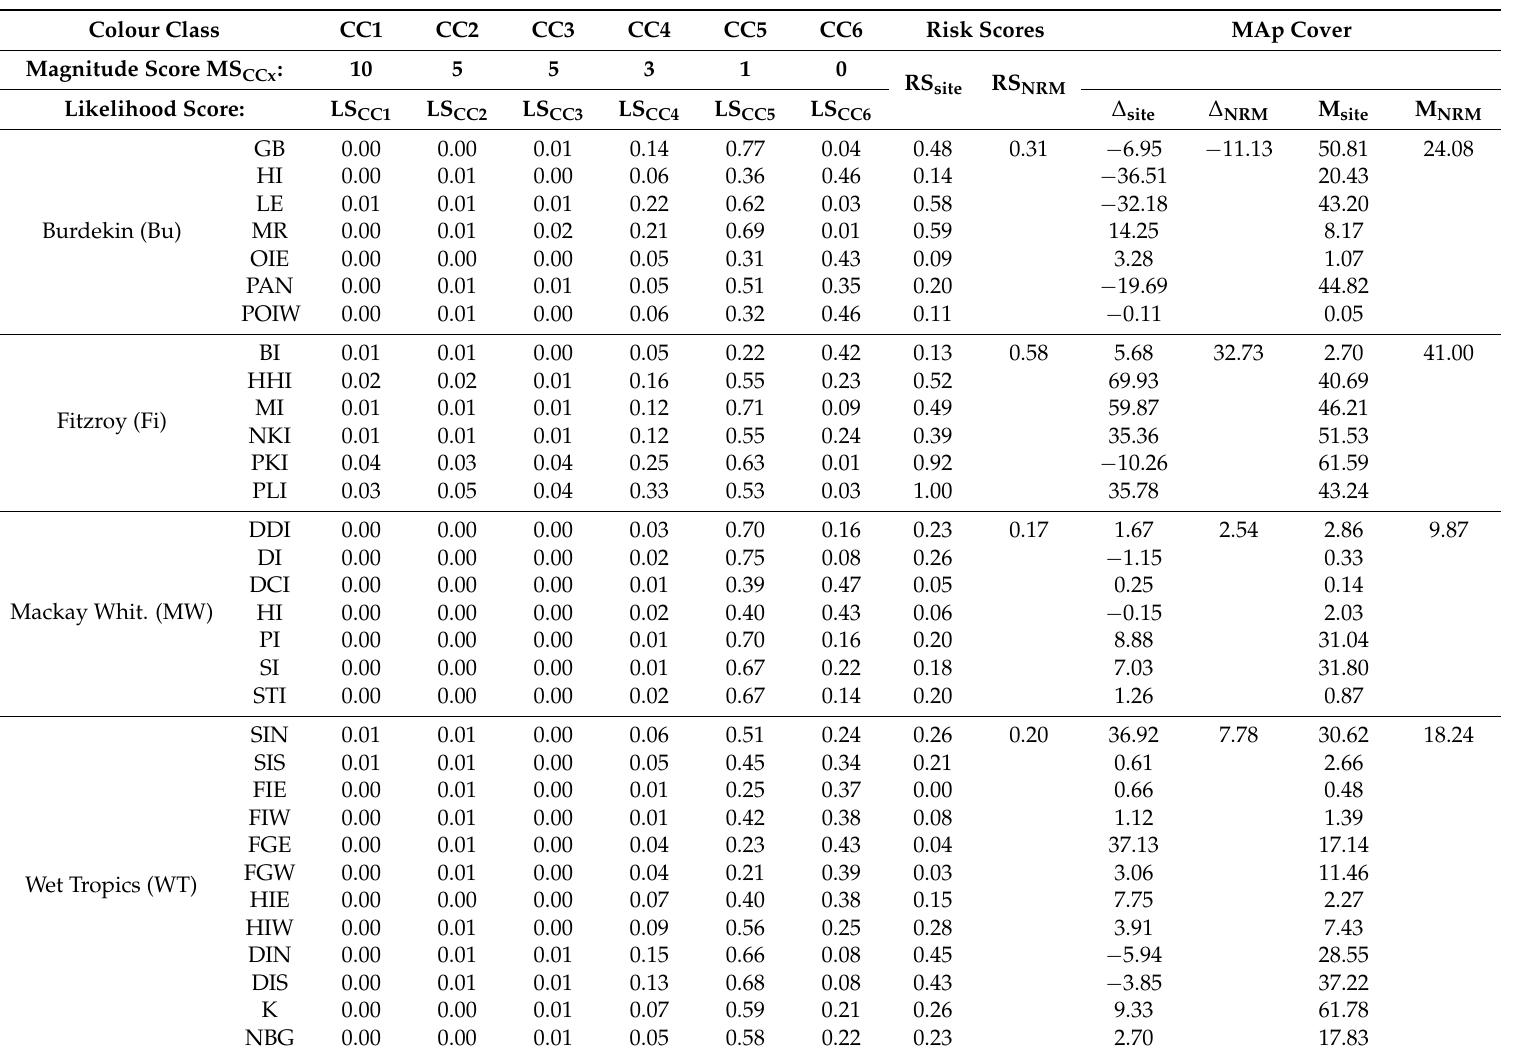
Table 4. Magnitude Score (MS CCx ) of each plume water type, Likelihood Score (LS CCx ) at the coral sites locations and risk scores (RS site and RS NRM ) at the coral site and NRM scales. The likelihood scores were extracted from the multi-annual (2005–2014) frequency composites by averaging the frequency values extracted in a 3km square buffer around each monitoring sites. MS CCx values are from Table 2 and the risk scores calculated following Equations (4) and (5). Multi-annual changes ( ∆ site and ∆ NRM, in %) and mean multi-annual (M site and M NRM , in %) MAp at the site and NRM scales are calculated following Equations (6) and (7). Full site names are given in the supplementary material ( Table S3